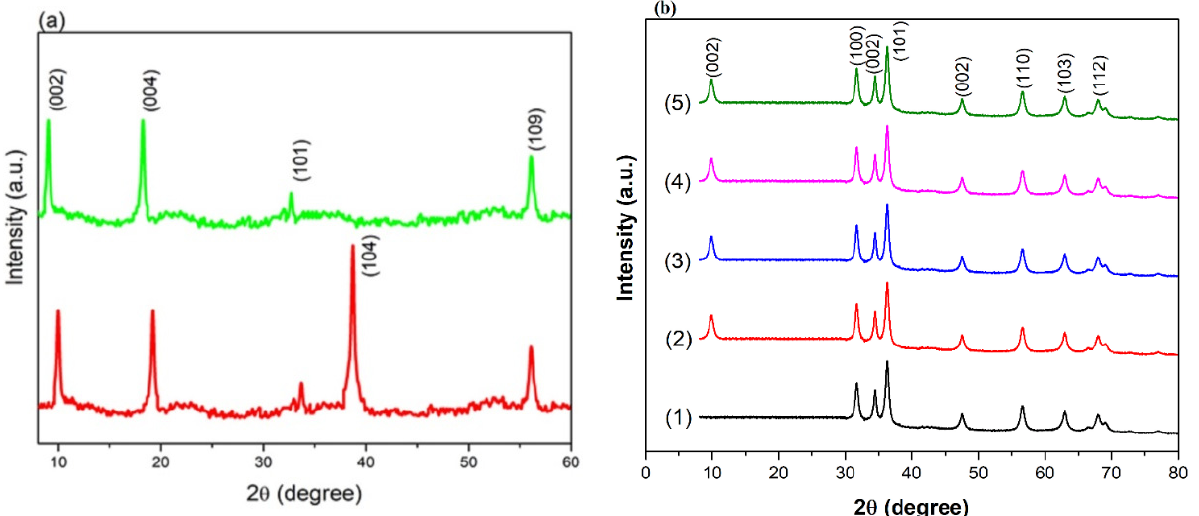
Figure 1. XRD spectra of ( a ) Ti 3 AlC 3 (red) and Ti 3 C 2 (green); ( b ) (1) ZnO, (2) ZnO 0.9 /TiC 0.1 , (3) ZnO 0.8 /TiC 0.2 , (4) ZnO 0.7 /TiC 0.3 and (5) ZnO 0.6 /TiC 0.4 composites.